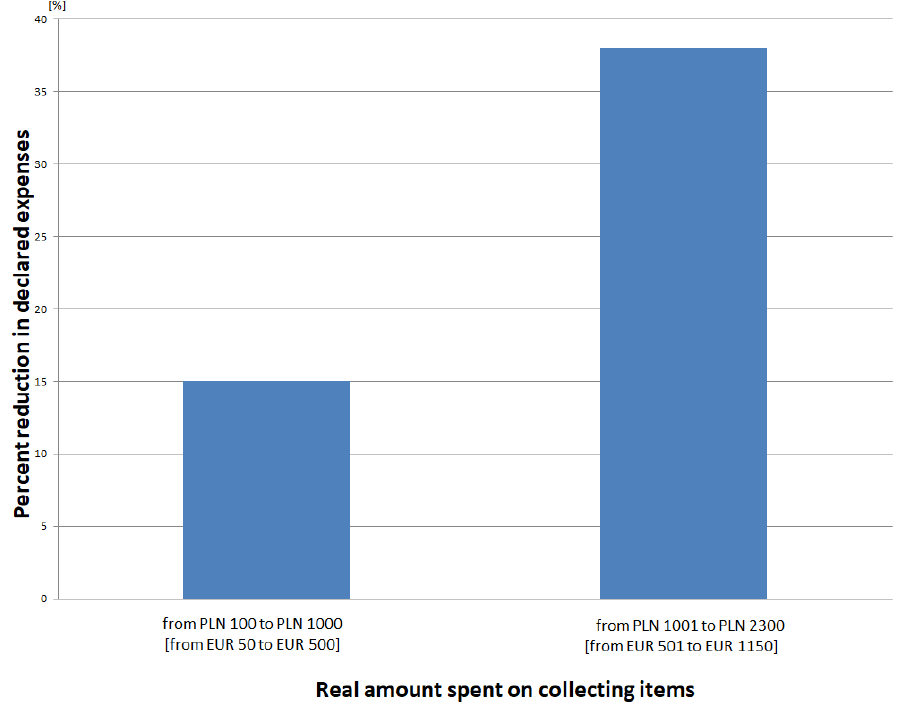
Figure 5. Percentage of reduction in the real amount of money that men spend on collecting items.